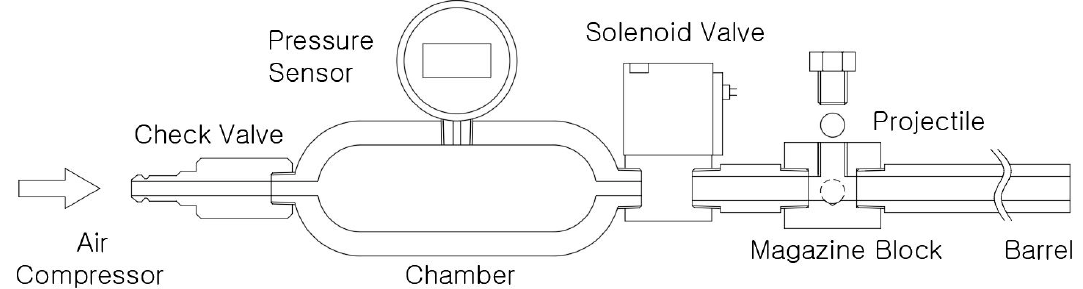
Figure 14. Design of launch device.